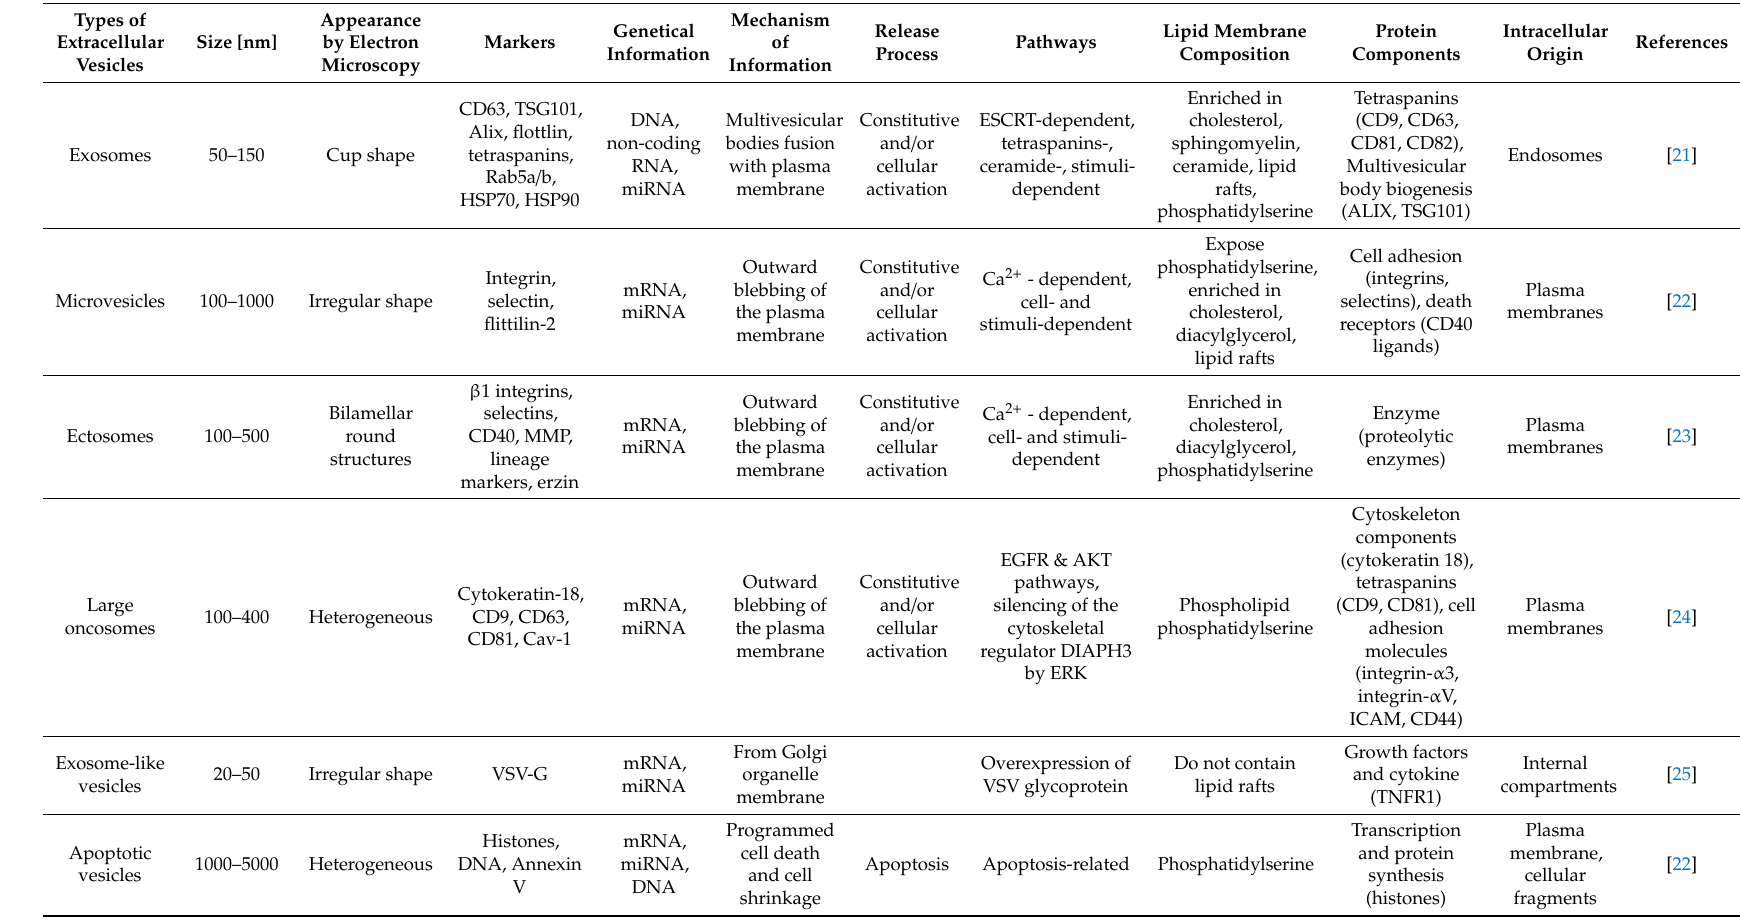
Table 1. The classification of extracellular vesicles and their main